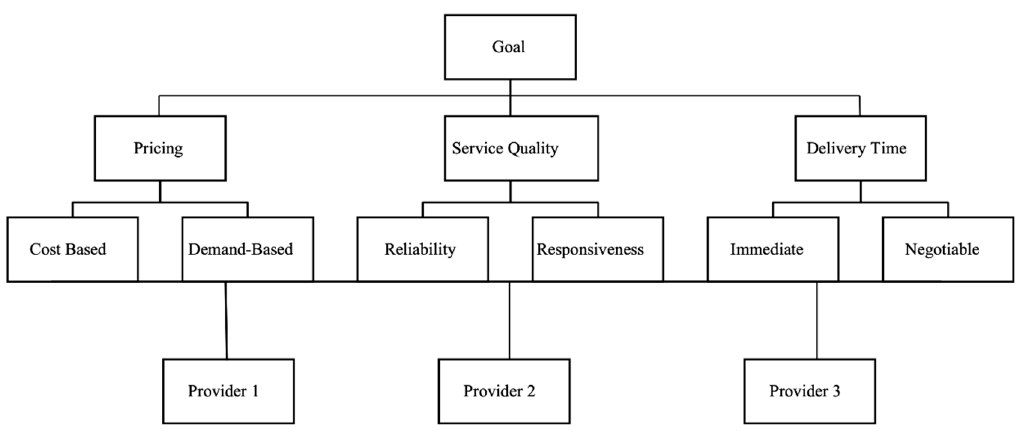
Figure 2. Decision Hierarchy [8].